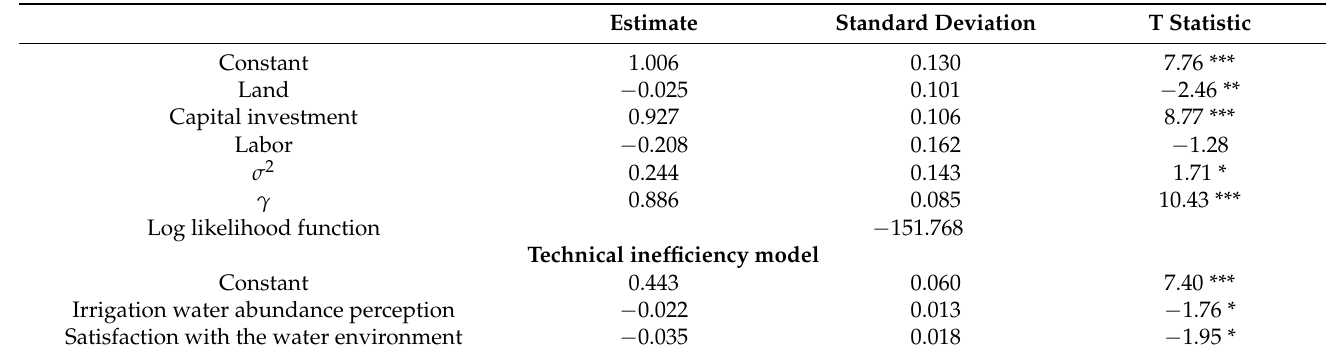
Table 4. Estimation of stochastic frontier model and technical inefficiency model.